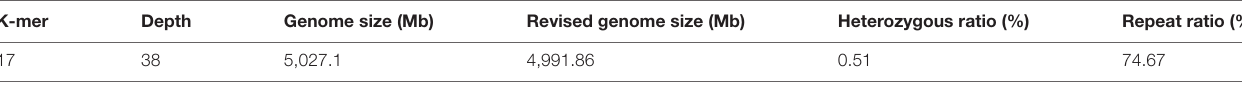
TABLE 2 | Estimation of Chiloscyllium plagiosum genome based on 17-mer statistics. K-mer